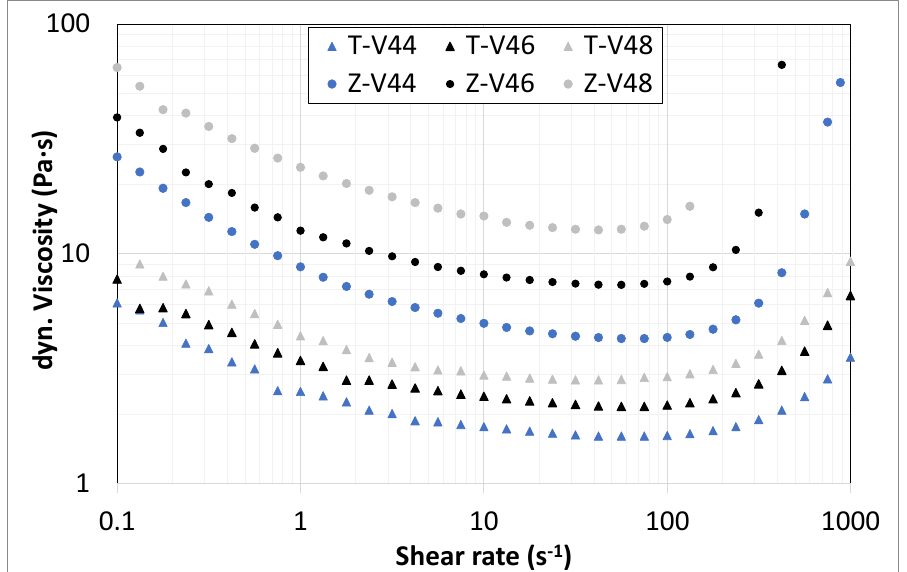
Figure 5. Viscosity of titania (triangles) and zirconia (circles) slurries based on rc2 depending on shear rate; solids content of 44, 46 and 48